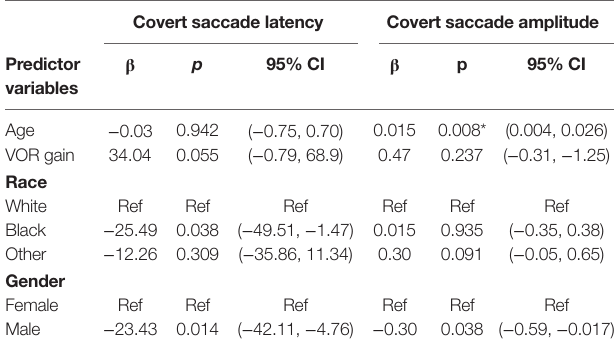
TaBle 2 | relationship between latency and amplitude of the first covert saccade and age controlling for VOr gain.